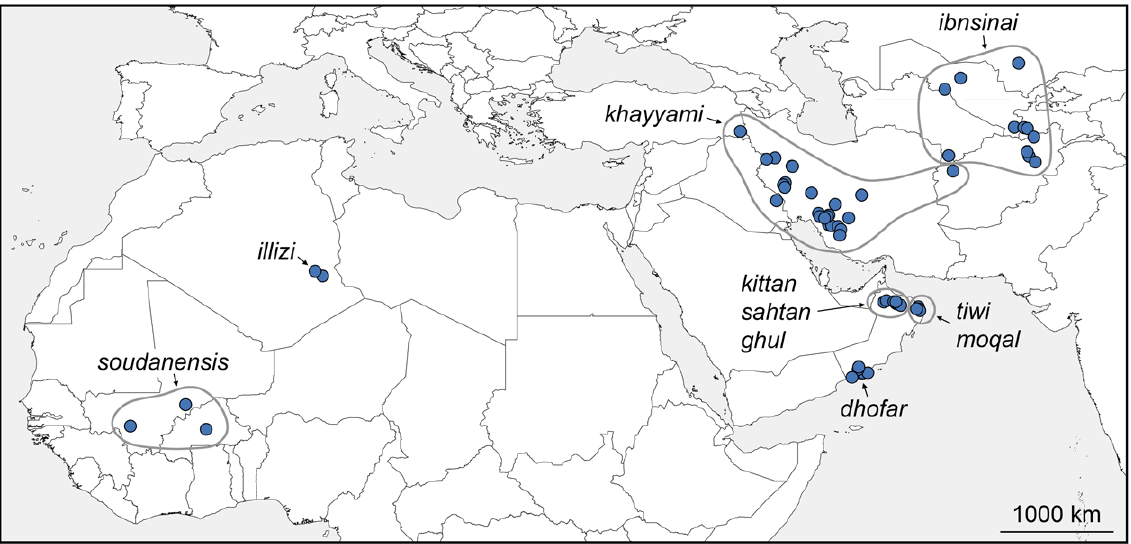
Fig. 352. Distribution of Crossopriza Simon, 1893; autochthonous species part 1 (cf. Fig. 353): species with main cheliceral apophyses in lateral